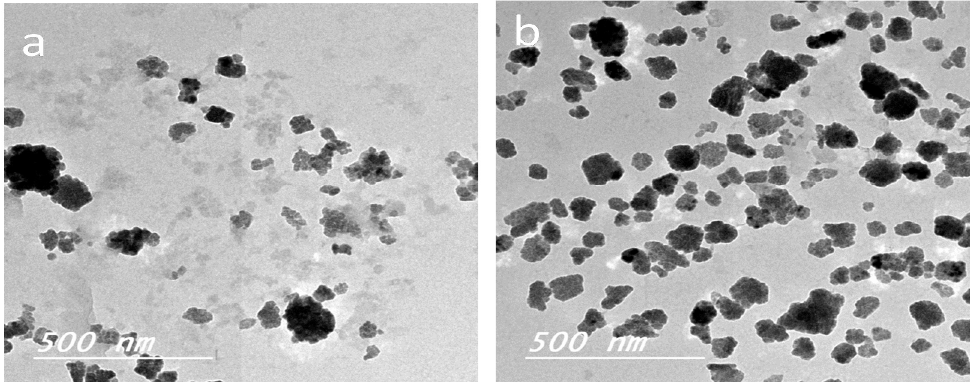
Figure 6. TEM images of castor oil-in-water emulsions: ( a ) non-stabilized and ( b ) stabilized.